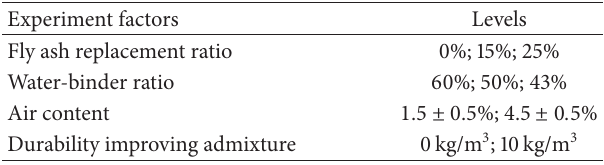
Table 3: Experiment factors and